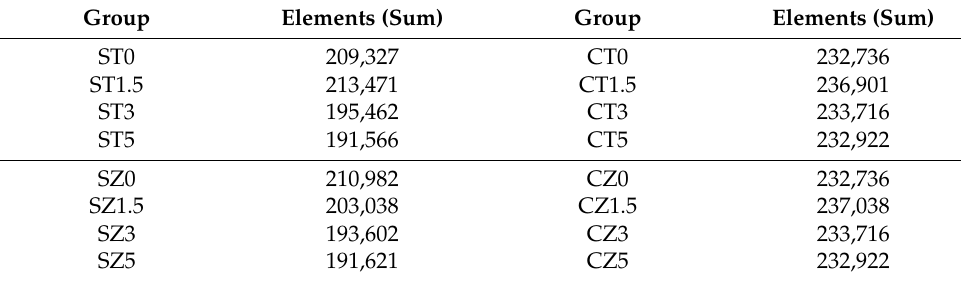
Table 3. Element numbers of finite element models.